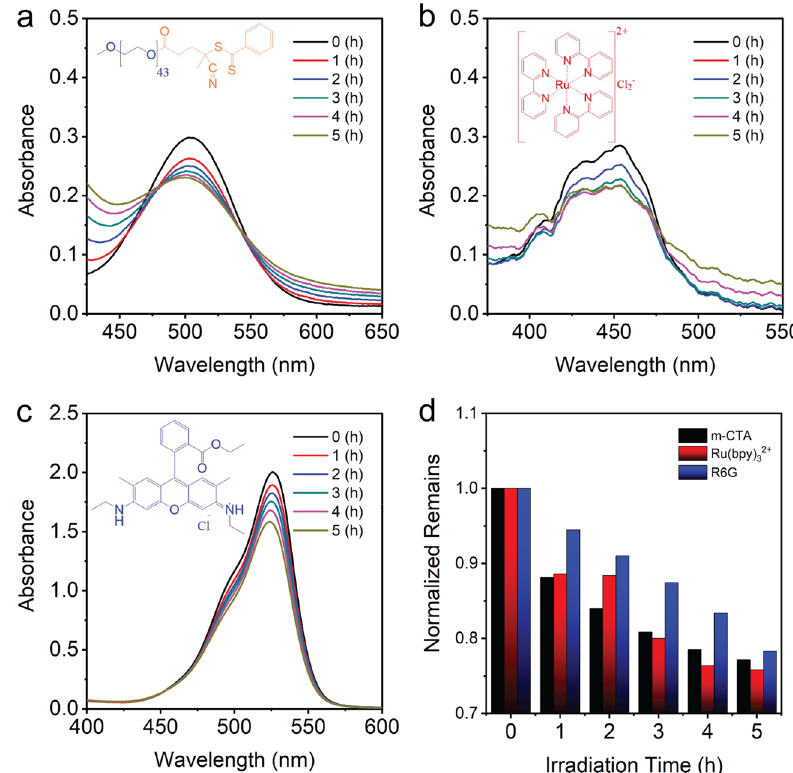
Fig. 3 UV – VIS spectral analysis. Photo-induced degradation of three chemicals in oxygen-rich aqueous solutions: a Macro-RAFT agent, b Ru(bpy) 3 2 + , c Rhodamine 6 G, d Normalized remaining levels of the corresponding photo-degraded chemicals used in PET-PISA